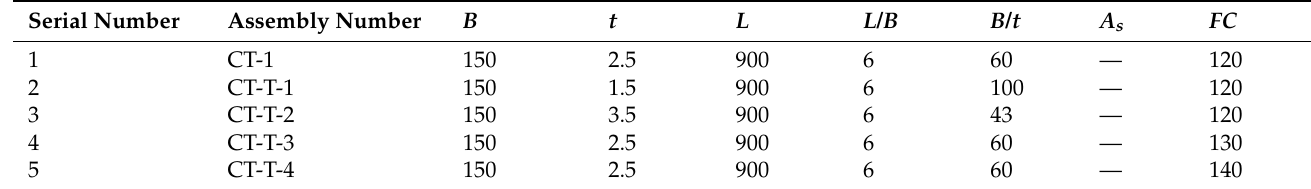
Table 8. Expanded component design